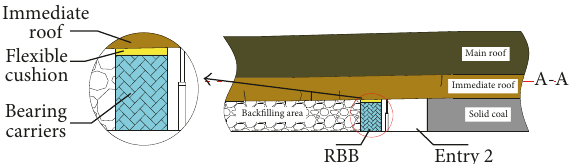
Figure 3: RBB structure of GER with fully mechanized backfilling